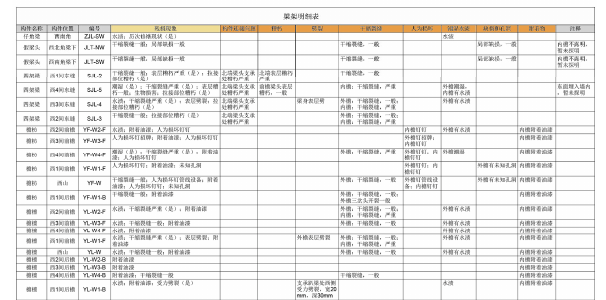
Figure 20 Example of using “Defect phenomenon” (in yellow) and 8 themes of “Defect description” (in orange)